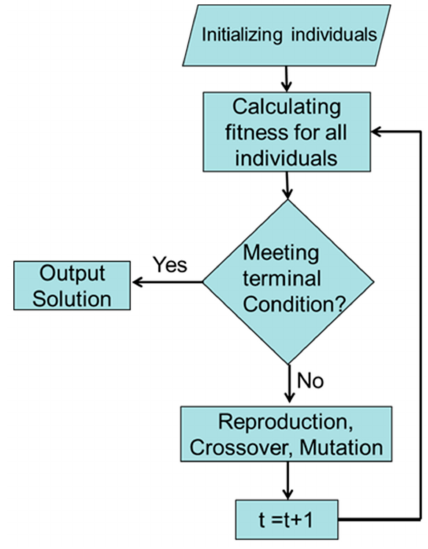
Figure 6. Genetic algorithm